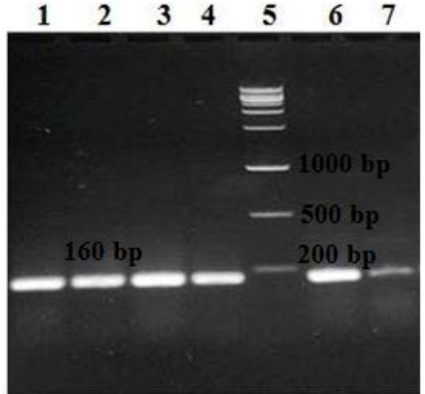
Fig. 3. Detection of the intI gene on 1.5% agarose gel following amplification with PCR. Lanes 1, 2, 3, 4, 6, and 7: six isolates positive for the intI gene detected at 160 bp and lane 5: the DNA